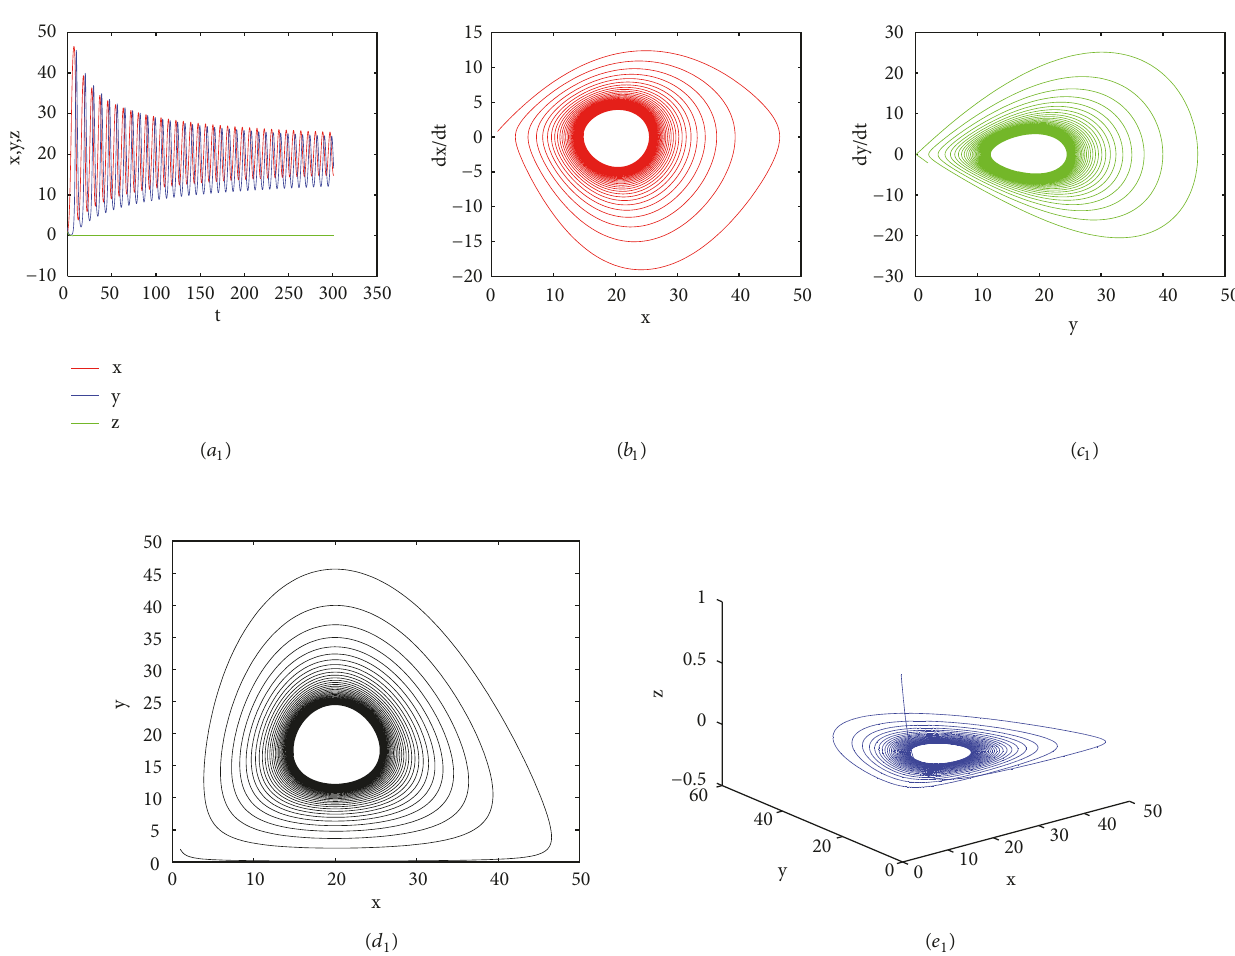
Figure 1: The three species food chain model for Experiment 1 with 𝑟 = 1 : (𝑎 1 ) time series plot; (𝑏 1 ) phase diagram of 𝑥 ; (𝑐 1 ) phase diagram of 𝑦 ; (𝑑 1 ) projected on the (𝑥,𝑦) -plane; (𝑒 1 ) on the three-dimensional space.